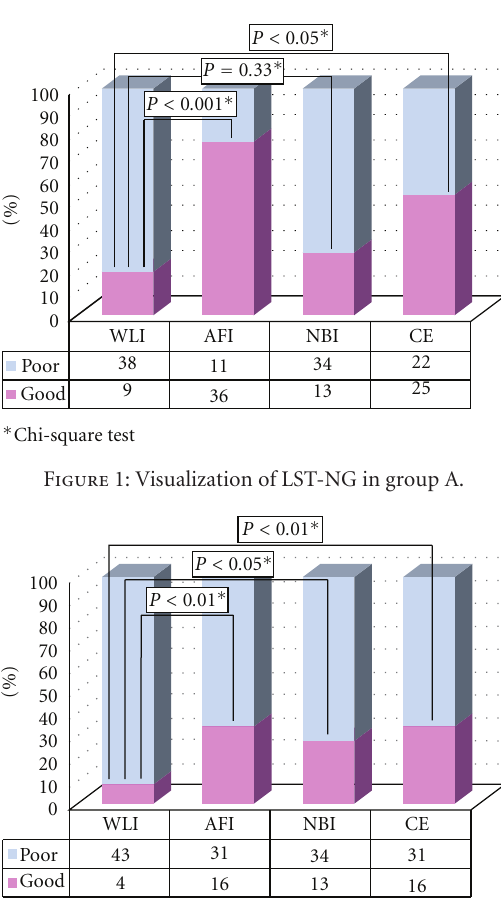
Figure 2: Visualization of LST-NG in group